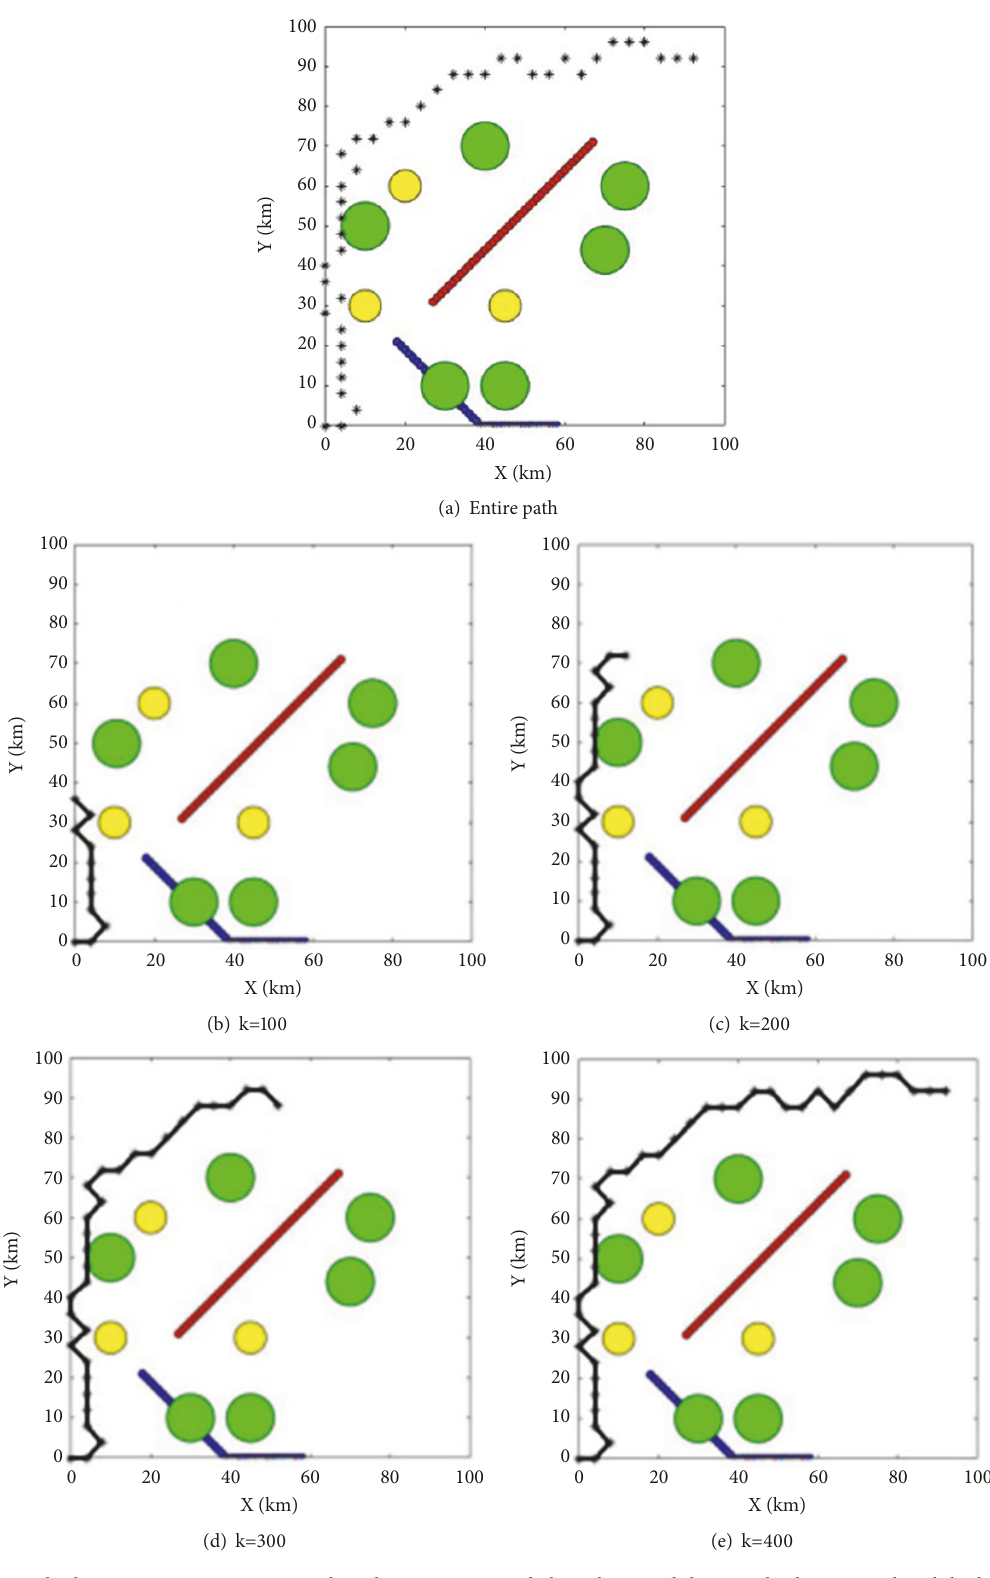
Figure 8: UAV path planning in one environment based on our proposed algorithm. And there are both static and mobile threats where (a) is an entire path and (b) to (e) are paths with iterations = 100, 200, 300,